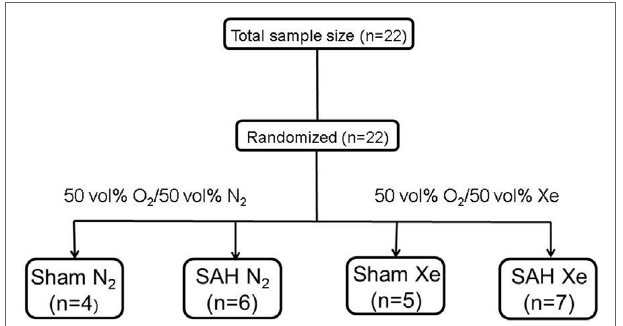
Figure 1 | Flow chart of included animals. Animals were randomized by lot drawing in one of four groups. Sham N 2 (Sham surgery after 1 h